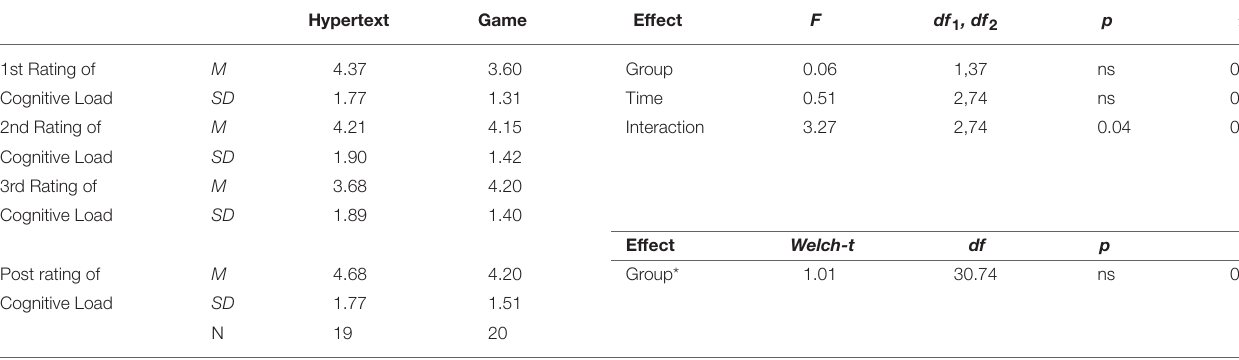
TABLE 5 | Means and standard deviations and the test results of the cognitive load analyses. Hypertext Game